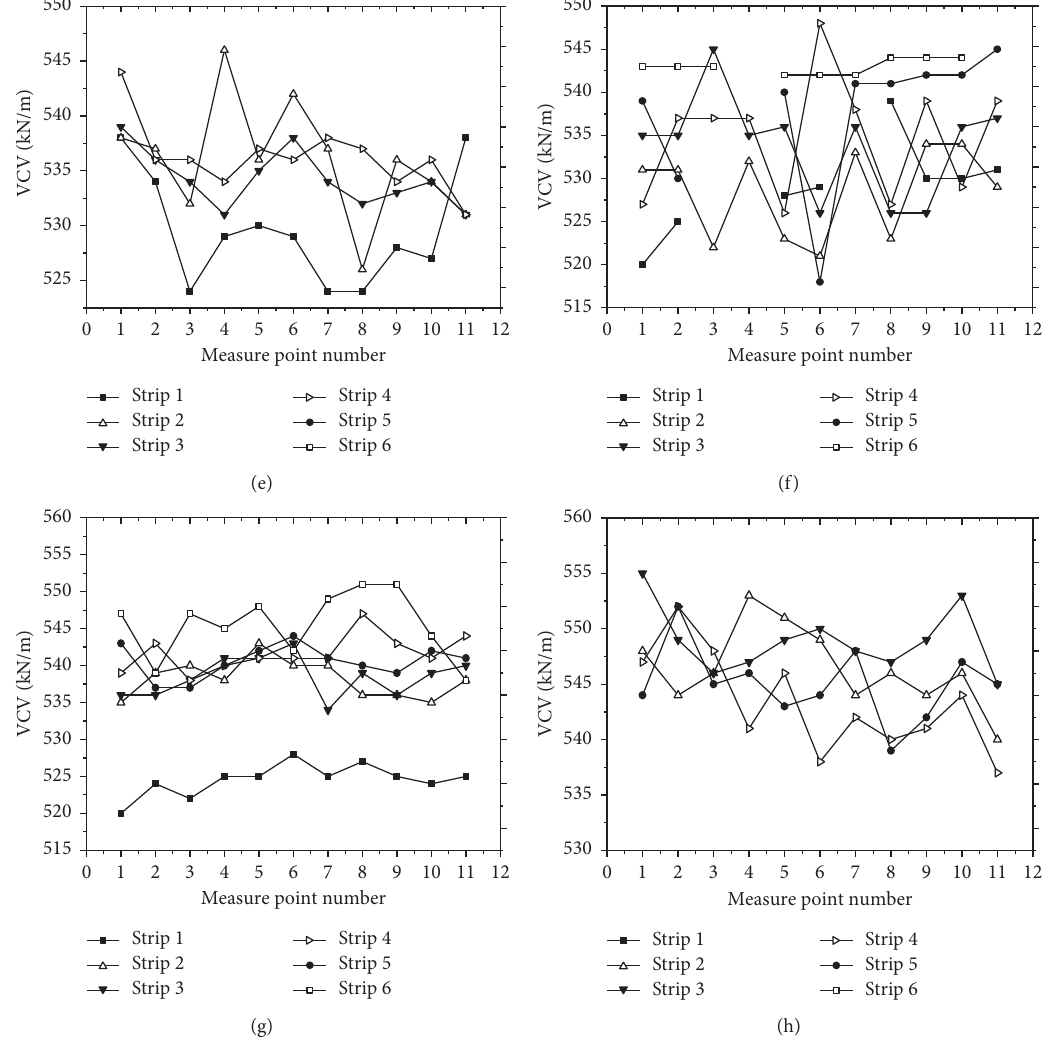
Figure 4: VCV test results. (a) WC 1; (b) WC 2; (c) WC3; (d) WC 4; (e) WC 5; (f) WC 6; (g)WC 7; (h) WC